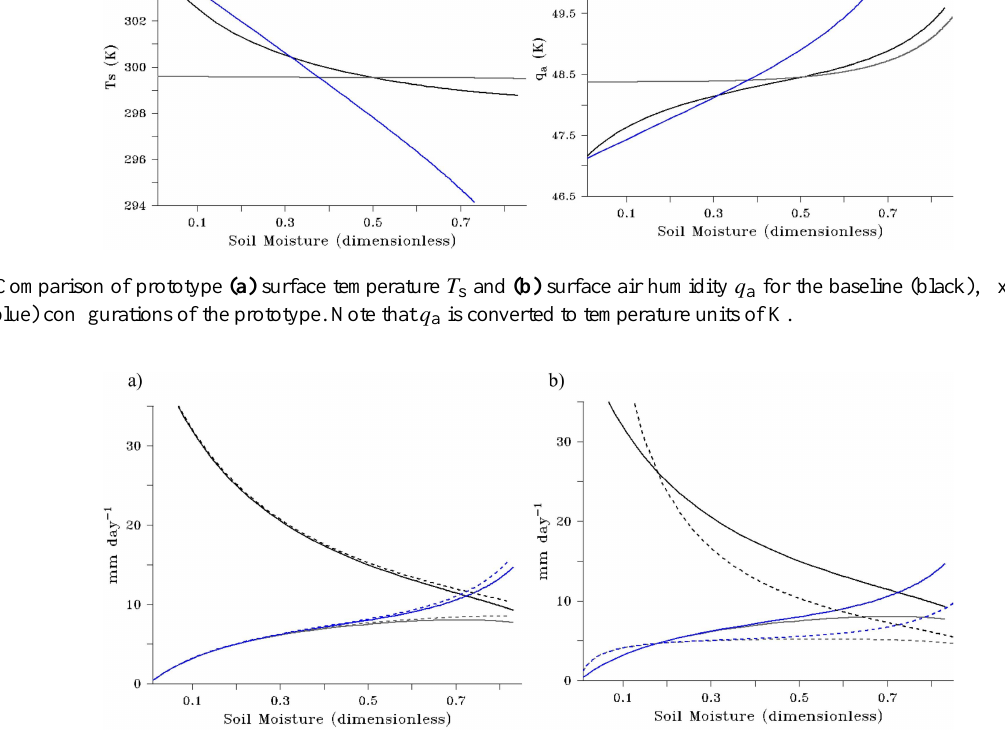
Figure 6. Impact on the complementary relationship from prescribing either (a) net surface radiative heating or (b) sensible heat flux. The curves depicted correspond to E p (black), E (gray), and P (blue) for the baseline configuration (solid) and prescribed radiative or sensible heat fluxes